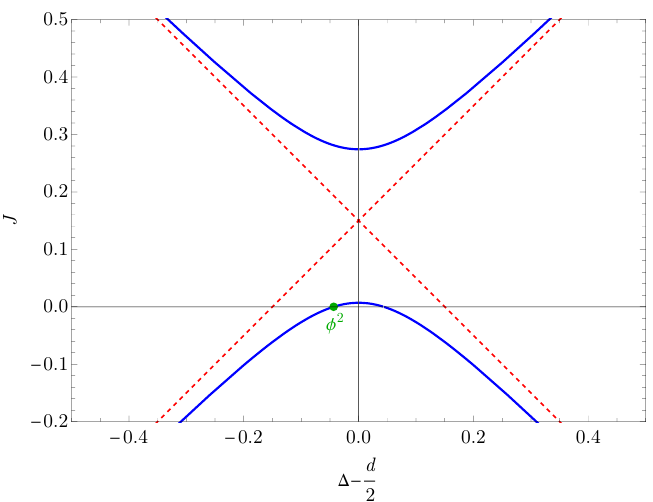
Figure 8. Chew-Frautschi plot of the leading Regge trajectory in Wilson-Fisher theory near the intercept at O ( (cid:15) 4 ) . This is same as figure 5, but zoomed in to show the location of the φ 2 operator (more accurately, L [ φ 2 ]